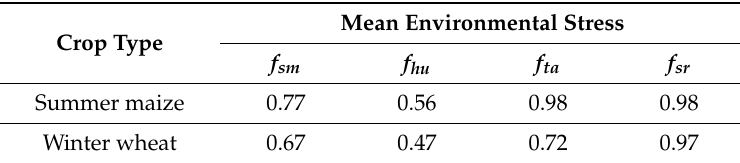
Table 3. Mean environmental stress values for maize and